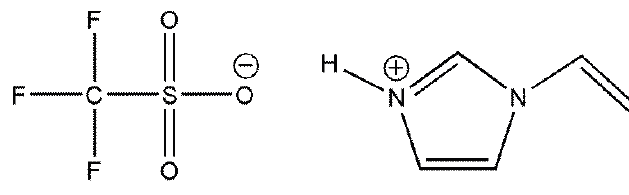
Figure 1. Chemical structures of PIL